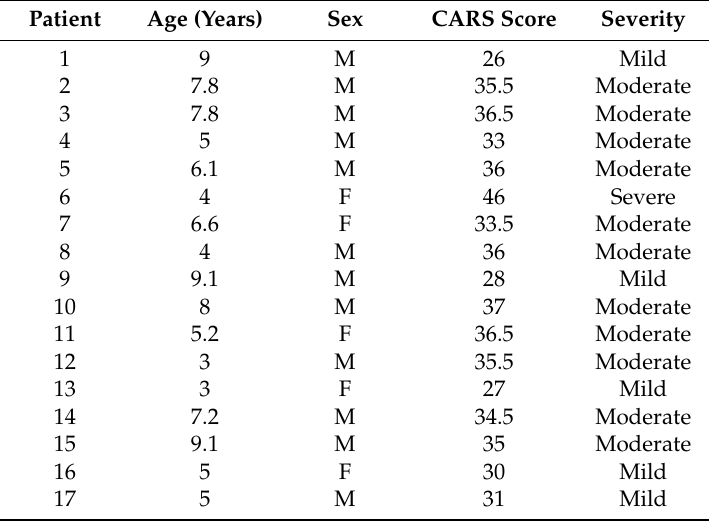
Table 1. Clinical and demographic characteristics of autistic patients. CARS, Childhood Autism Rating Scale; M, male; F,